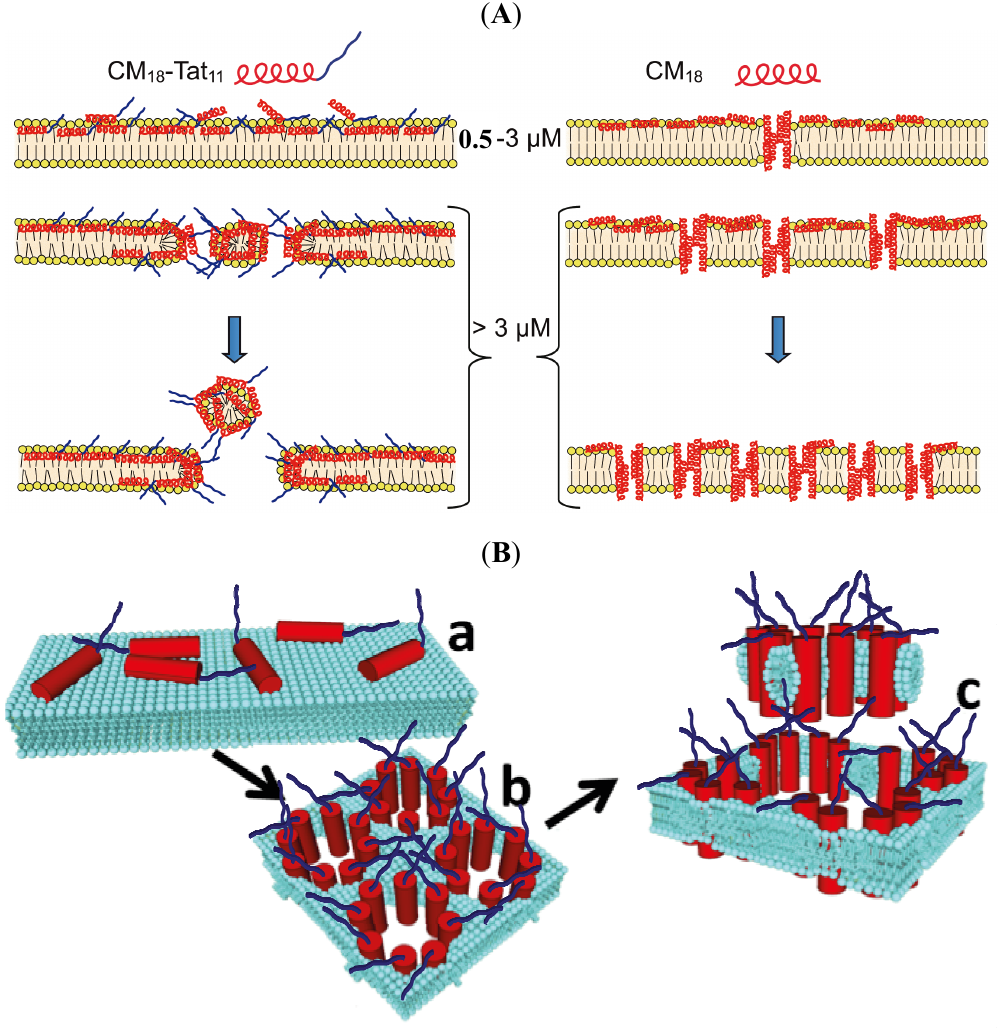
Figure 5. ( A ) Schematic representation of the membrane destabilization mechanism proposed for CM -Tat (left) and CM (right) peptides. CM moiety is pictured as a red 18 11 18 18 helix, while Tat moiety is represented as an unstructured blue segment. The 11 upper part describes for each peptide its hypothetical membrane distribution when it is administered in the range between 0.5–3 µM. Instead the lower section represents the membrane distribution at concentrations higher than 4 µM. ( B ) Alternative mechanism of permeabilization operated by the CM -Tat monomers, illustrated as red cylinders (CM ) 18 11 18 plus blue segments (Tat 11